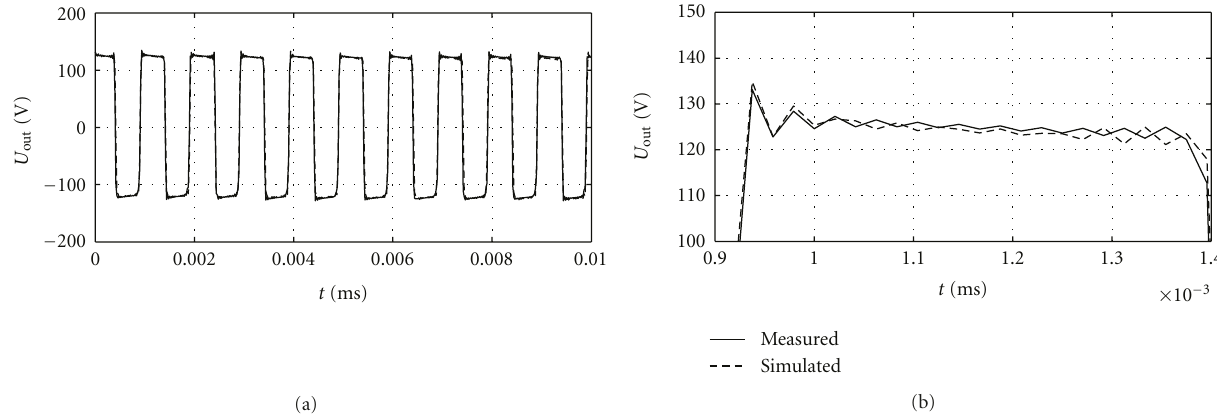
Figure 10: Comparison between measured and simulated preamp. The input voltage was sinewave signal with an amplitude of 150mV and a frequency of 1 kHz.